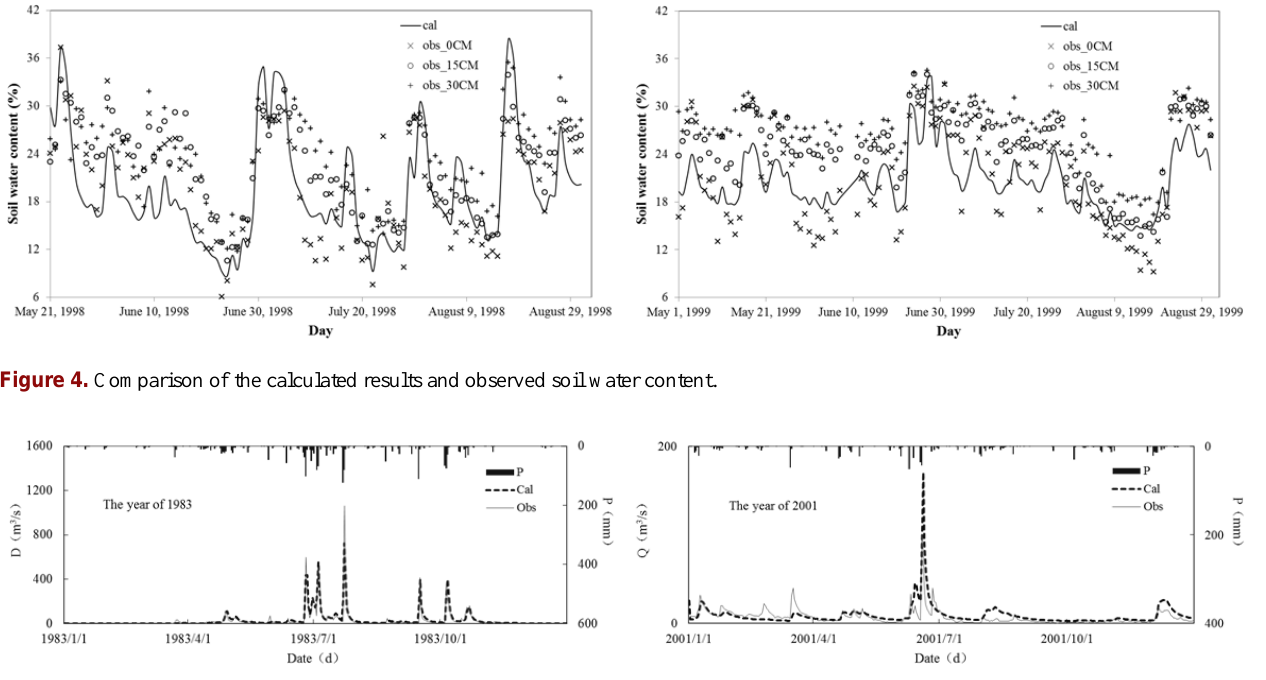
Figure 5. Comparison of the calculated results and observed daily hydrological